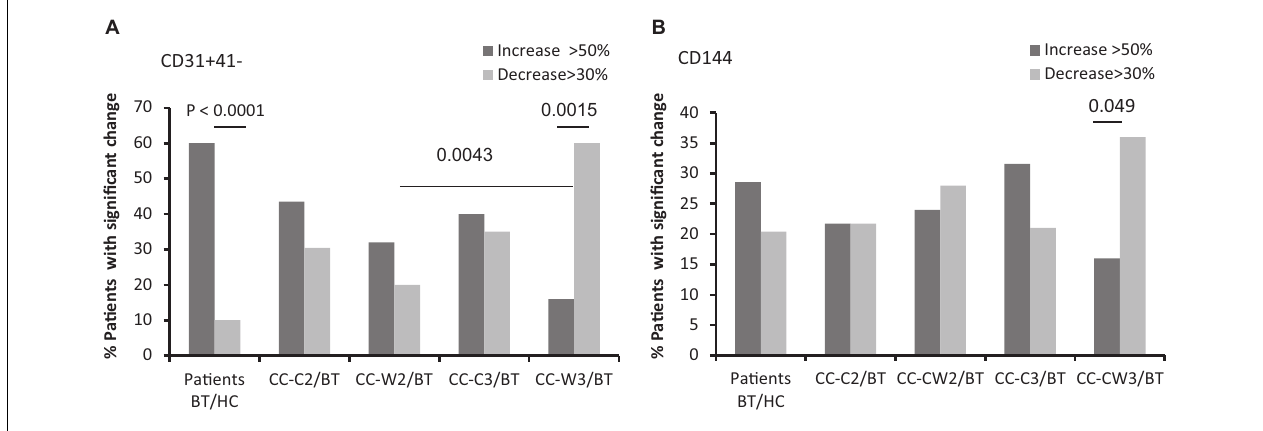
FIGURE 4 | EVs endothelial cell markers. Antigen levels of endothelial markers were measured on EVs obtained from healthy controls and on EVs obtained from patients (CC-C and CC-W) before chemotherapy (BT, time point 1), during treatment (time point 2), and at the end of chemotherapy treatment (time point 3). The percentage of labeled EVs was calculated from the total number of EVs using FACS analysis. The graph presents significant changes ( > 50% increase or > 30% decrease) in patient EVs levels BT compared to HC and the change during treatment and at the end of chemotherapy treatment compared to the levels BT of EVs CD31 + /CD41 (A) ; EVs CD144 (B) .